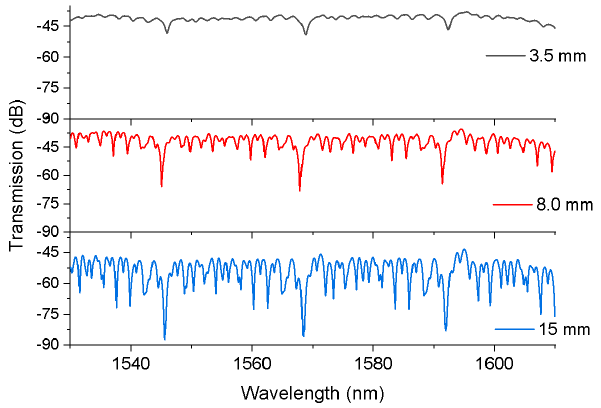
Figure 3. Measured transmission spectra of the SMF–HCF–SMF fiber structure with different lengths of HCF (3.5, 8.0, and 15 mm).